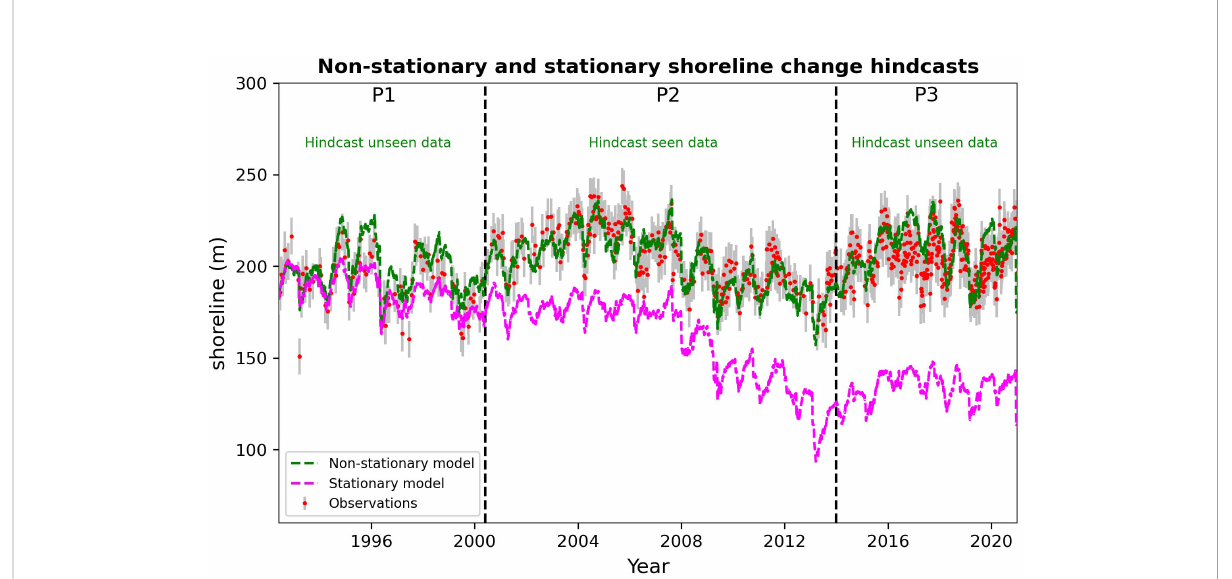
FIGURE 5 Comparison of shoreline predictions using non-stationary (green line) and stationary (magenta line) parameters with the ShoreFor model when b = 0 . Both hindcasts were initialized from the same shoreline position in ~January 1992 and run forward in time using Equation